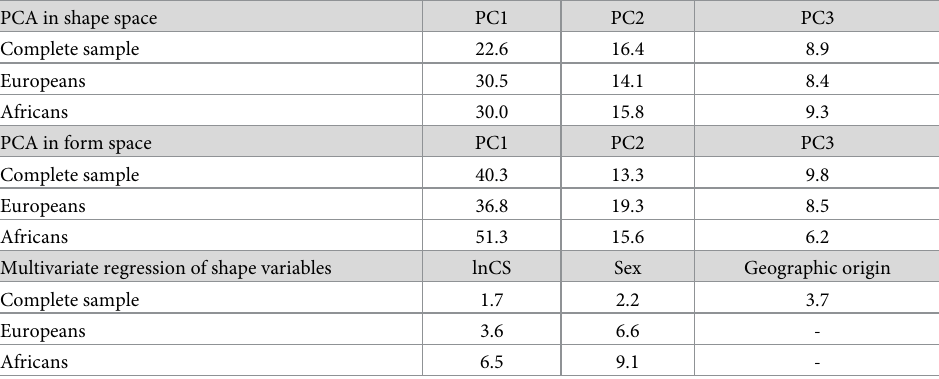
Table 3. Percentages of principal component (PC) explained variances in both shape and form space, and percent- ages of accounted variance by selected independent variables yielded by the multivariate regressions (natural loga- rithm of centroid size lnCS, sex, and geographic